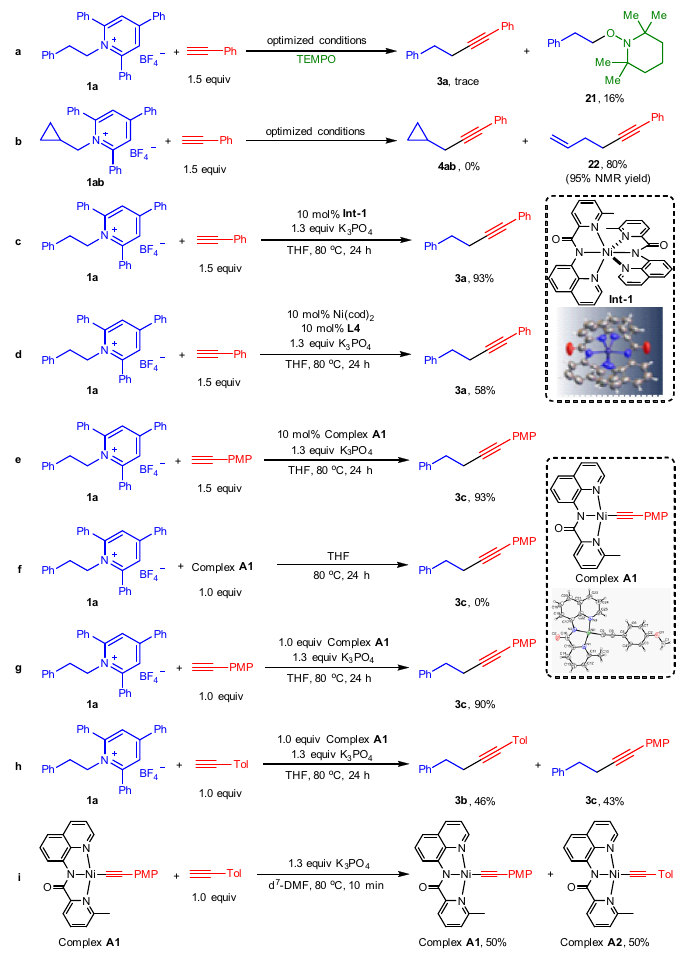
Fig. 6 Preliminary mechanistic studies. a Radical trap experiment. b Radical clock experiment. c Catalytic transformation using Int-1 as catalyst. d Catalytic transformation using Ni(cod) 2 as catalyst. e Catalytic transformation using complex A1 as catalyst. f Stoichiometric reaction of complex A1 . g Stoichiometric reaction of complex A1 in the presence of terminal alkyne and base. h Crossover experiment of complex A1 . i Alkyne exchange experiment of complex A1 . PMP p -methoxyphenyl, Tol p -methylphenyl.